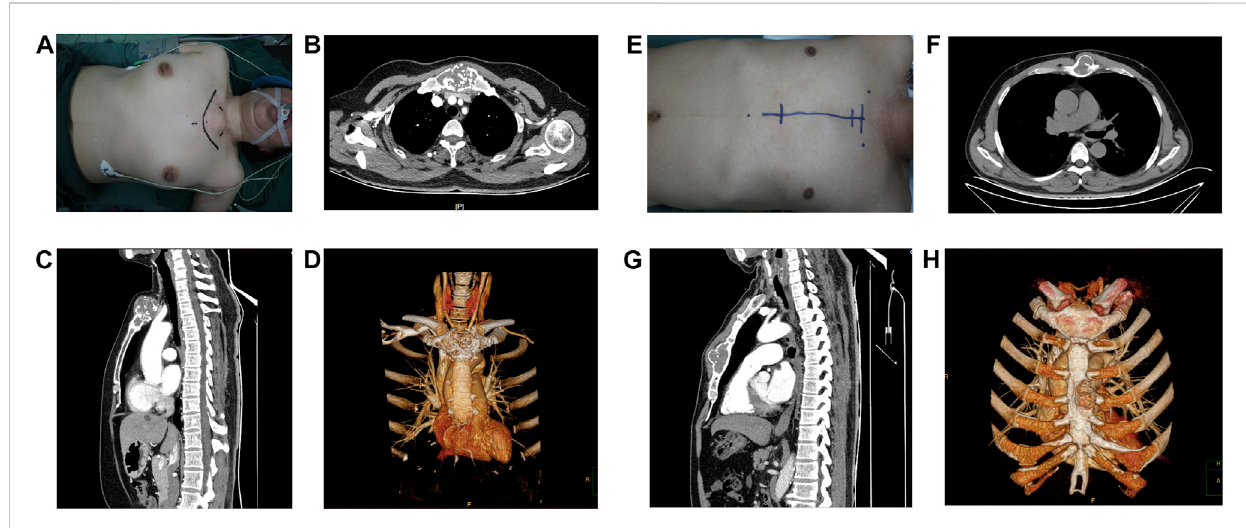
FIGURE 1 Appearance and preoperative images of the patients. (A – D) Female patient and (E – H) Male patient. (A,E) Appearance of the lesion and operative route on the body surface. (B,C) (F,G) The tumour is shown in cross-sectional and sagittal views (D,H ), (D) reconstruction of tumour on CT is